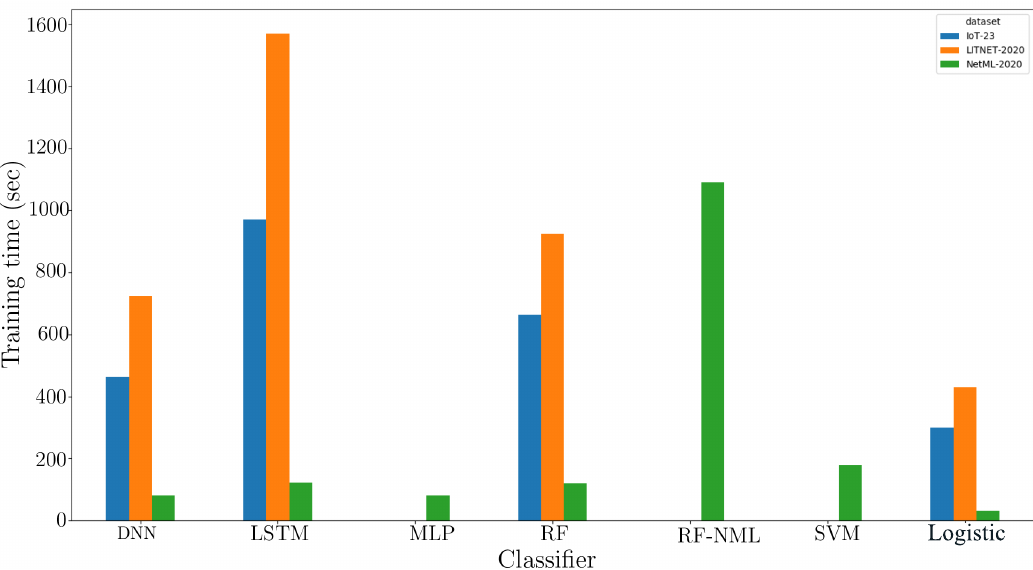
Figure 4. Training time taken by the proposed model vs. baseline models (RF, RF-NTML, SVM, MLP, DNN, and